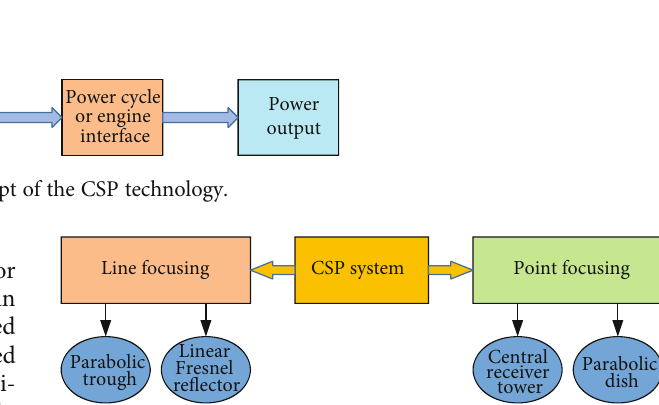
Figure 2: Flow diagram shows di ff erent CSP